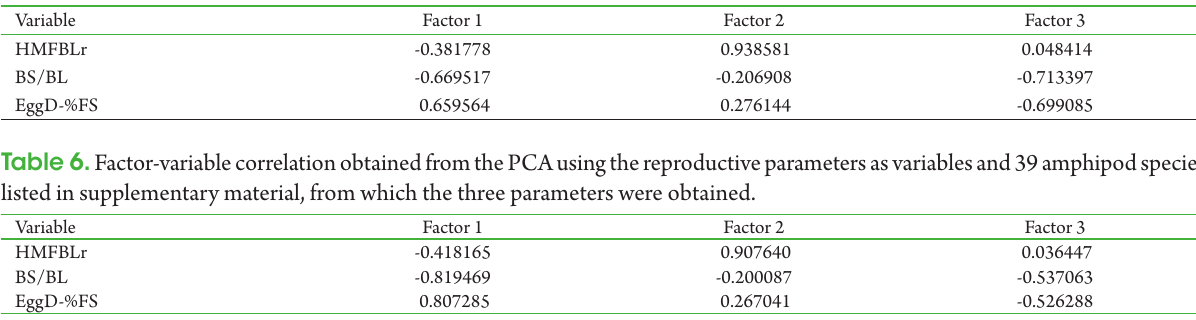
Table 5. Eigenvectors of correlation matrix obtained from the PCA using the reproductive parameters as variables for 39 amphipod species listed in supplementary material, from which the three parameters were obtained.